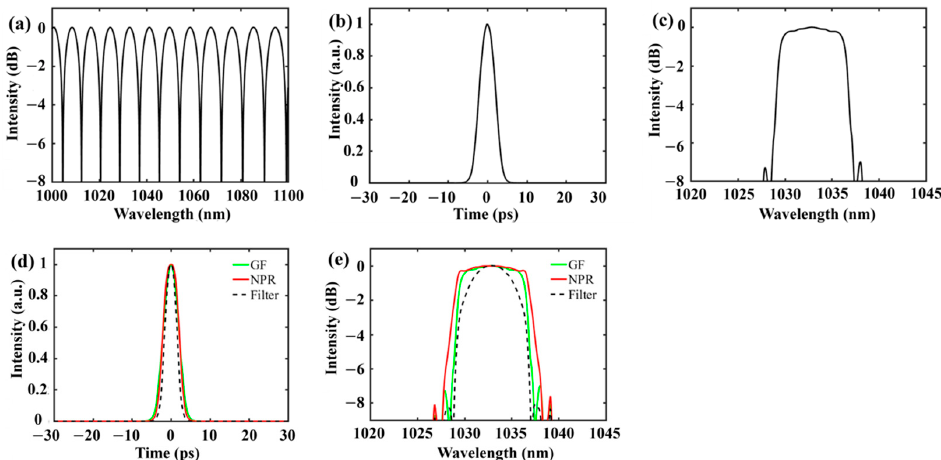
Figure 6. Simulation results with a filter bandwidth of 4.37 nm. ( a ) Transmissivity curve of the filter. ( b ) Pulse shape. ( c ) Output spectrum. ( d ) Pulse shape at different locations of the cavity. ( e ) Spectra at different locations of the cavity.